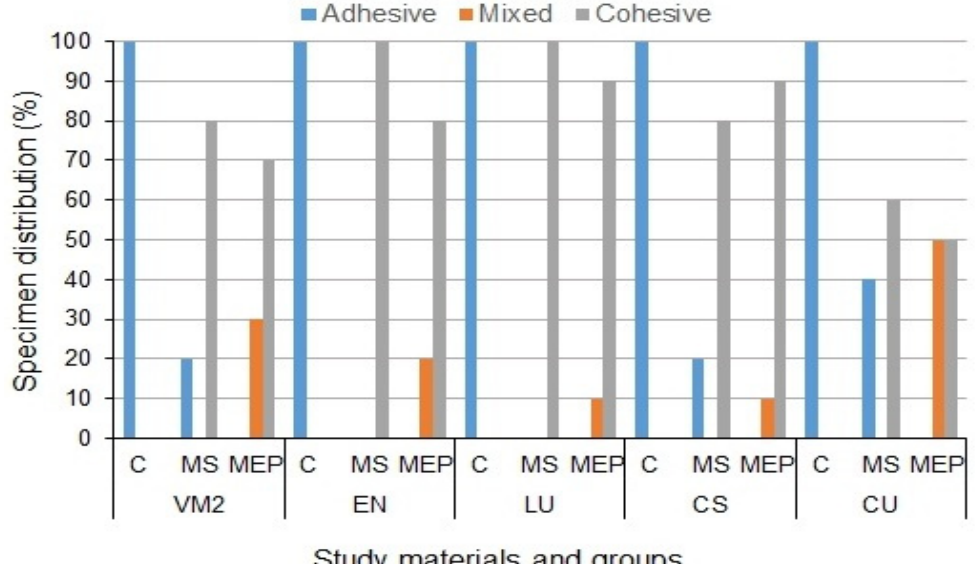
Figure 3. Failure mode analysis of the materials.